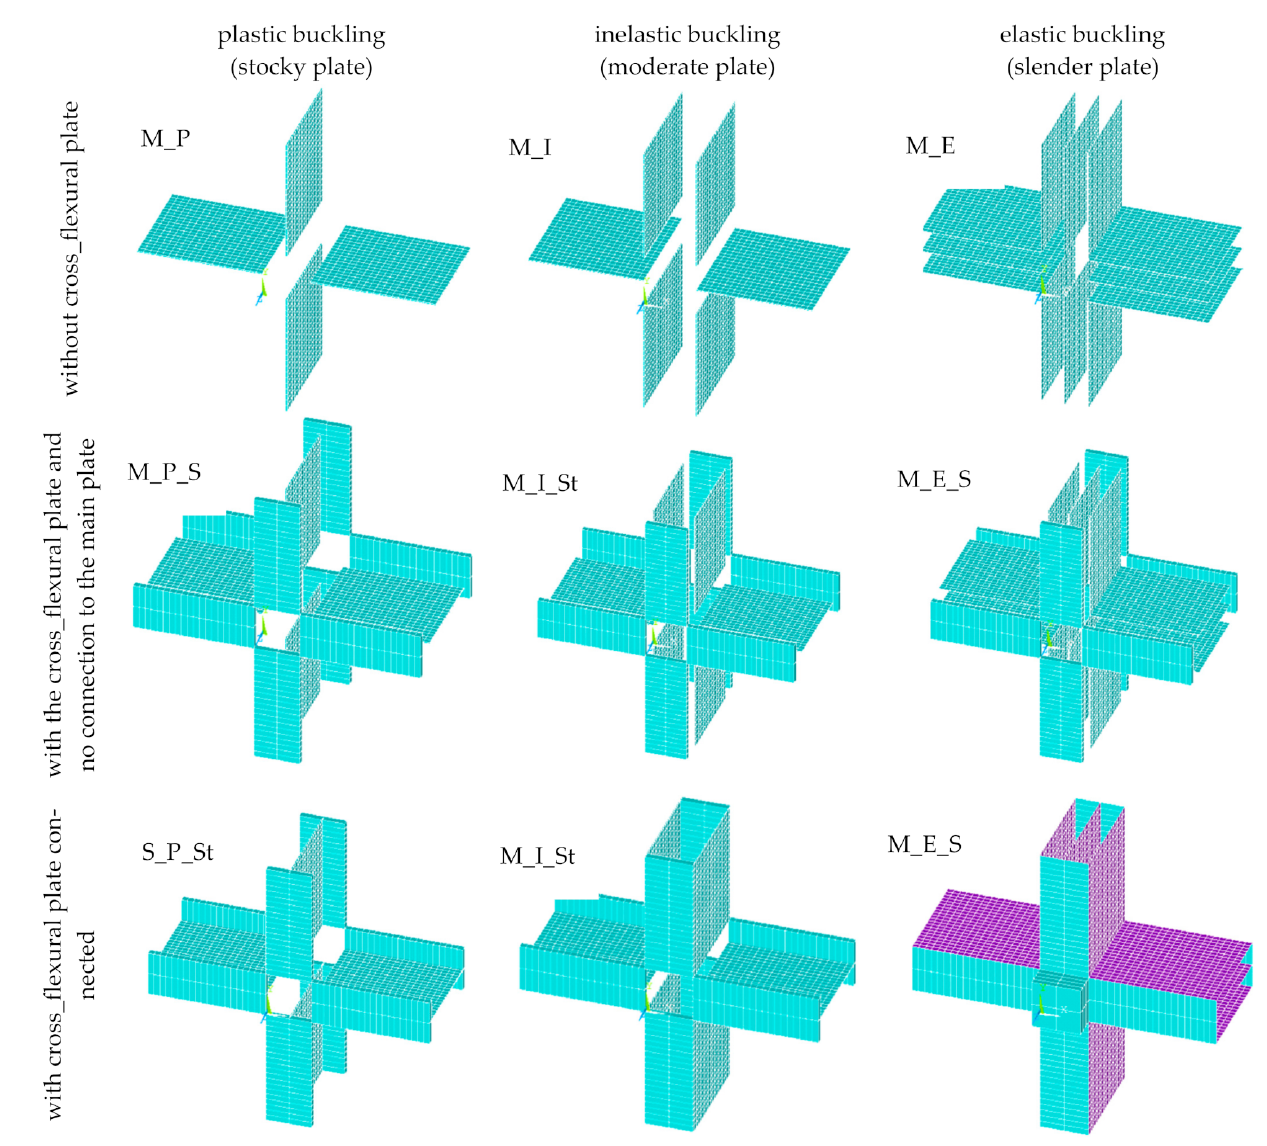
Figure 2. Dampers with different